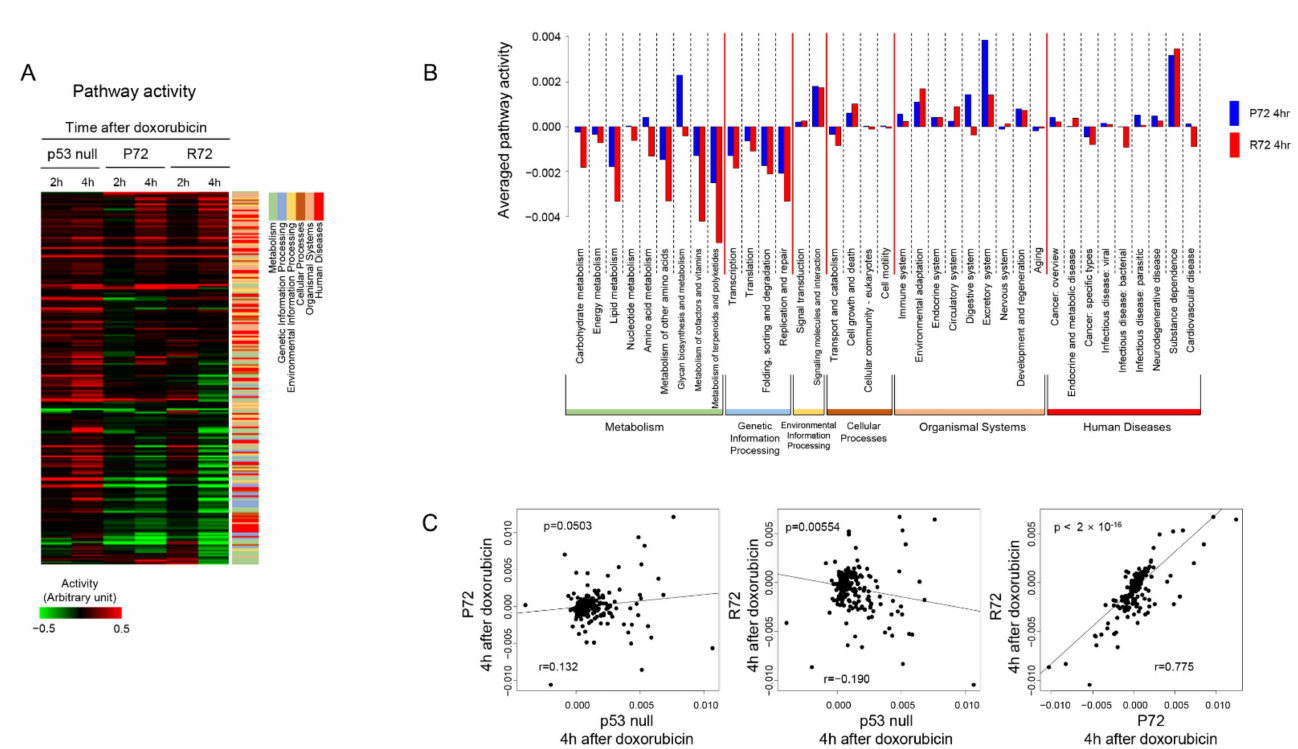
Figure 3. Effect of p53 status on doxorubicin-induced pathway activity. ( A ) Pathways were clustered according to the activity level in samples. Red and green indicate high and low activity levels, respectively, as indicated by the scale bar. Pathways were classified into six functional categories as indicated by color below. ( B ) Mean activity of pathways was measured according to functional category in P72 and R72 cells. ( C ) P72, R72, and p53 null cells were compared according to pathway activity